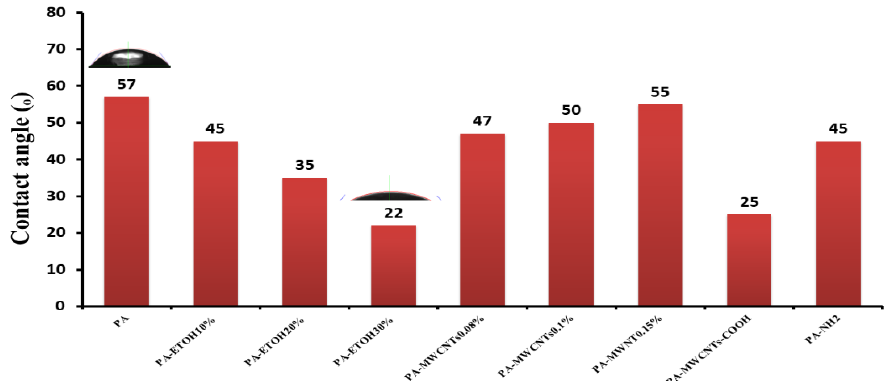
Figure 10. Contact angles of water droplets on the membrane’s surfaces containing PA, PA -EtOH (10%, 20%, and 30%), PA-MWCNTs (0.08%, 0.1%, and 0.15%), PA-MWCNTs-COOH, and PA- MWCNTs-NH 2